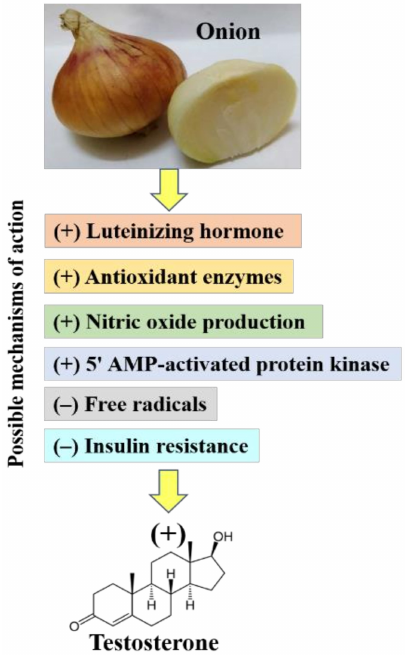
Figure 1. Possible mechanisms by which onion enhances testosterone production in